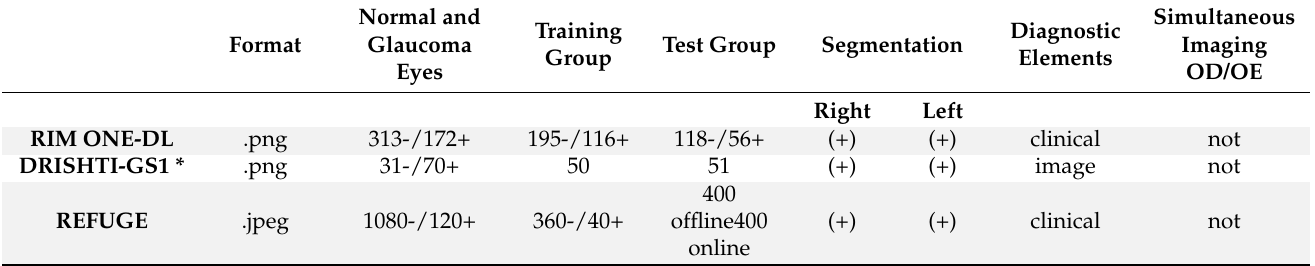
Table 2. Summarizes the characteristics of gold standard public databases.